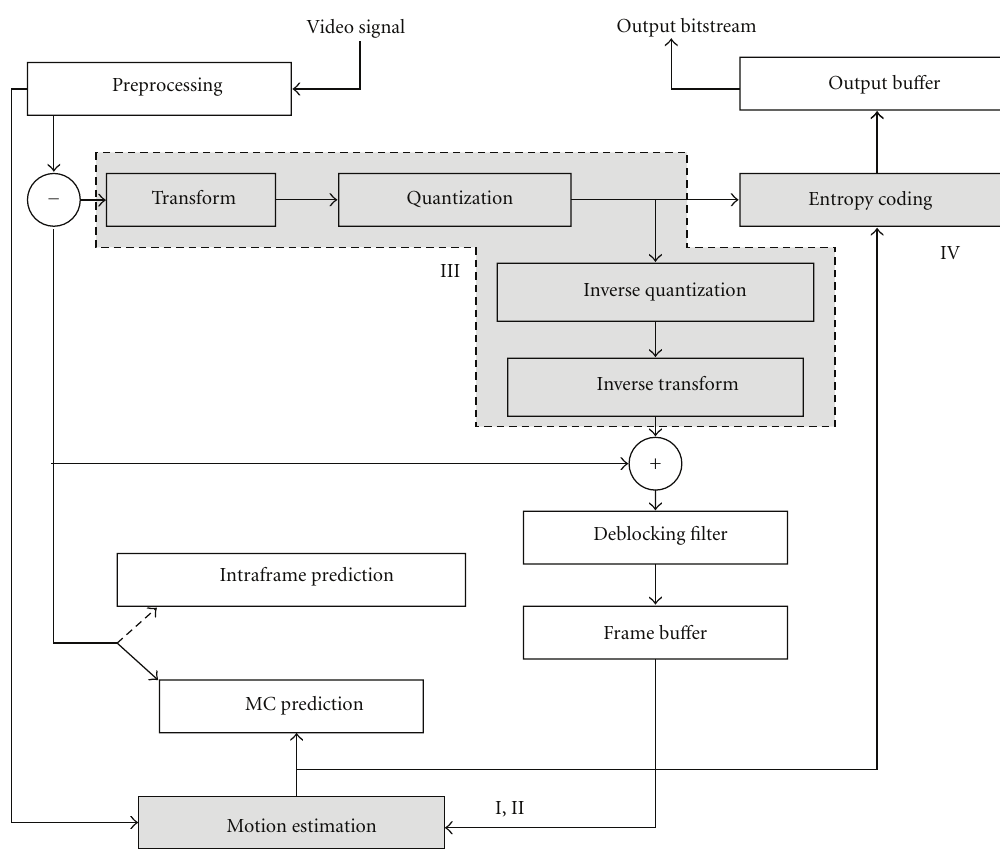
Figure 2: Block diagram of a standard H.264